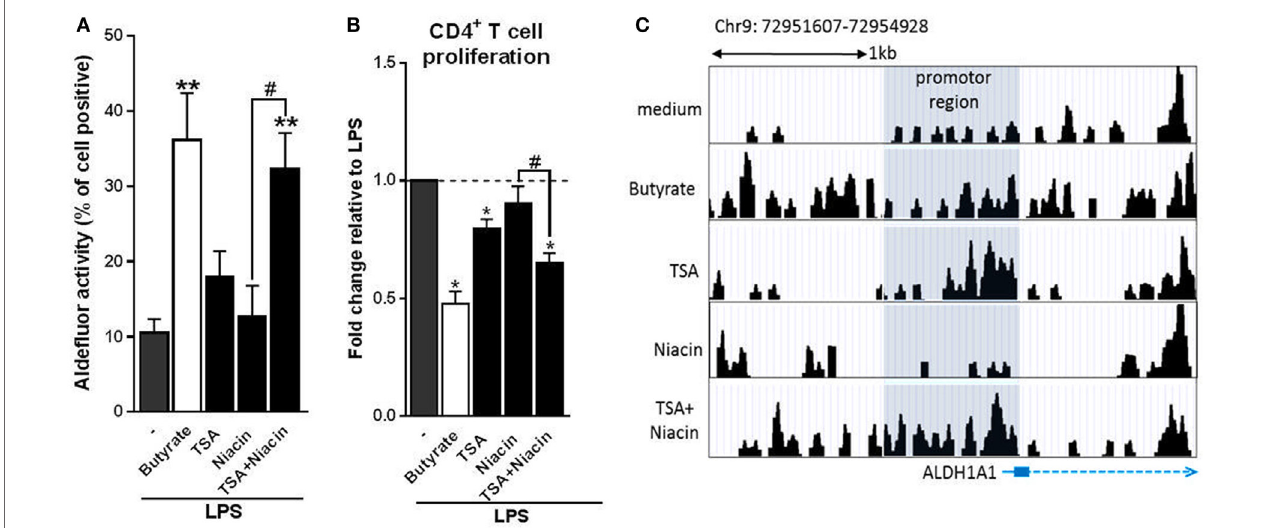
FigUre 6 | Butyrate depends on the combination of histone deacetylases inhibition and G protein-coupled receptor 109A signaling to prime type 1 regulatory T cell-inducing human tolDC. (a) Retinaldehyde dehydrogenase (RALDH) activity assay as described in Figure 3D . (B) T-cell suppression assay as described in Figure 2D . (c) Assay for Transposase-Accessible Chromatin with high-throughput sequencing analysis of the promoter region (highlighted in gray) of RALDH1 gene locus 6 h after stimulation of dendritic cells (DCs) with indicated reagents. (a) Bar graphs represent means ± SEM of at least three experiments and (B) are shown as fold change relative to control conditions. (c) Data from one of three experiments are shown. *,# p < 0.05, ** p < 0.01 for significant differences with the control (*) or between test condition ( # ) based on paired Student’s t